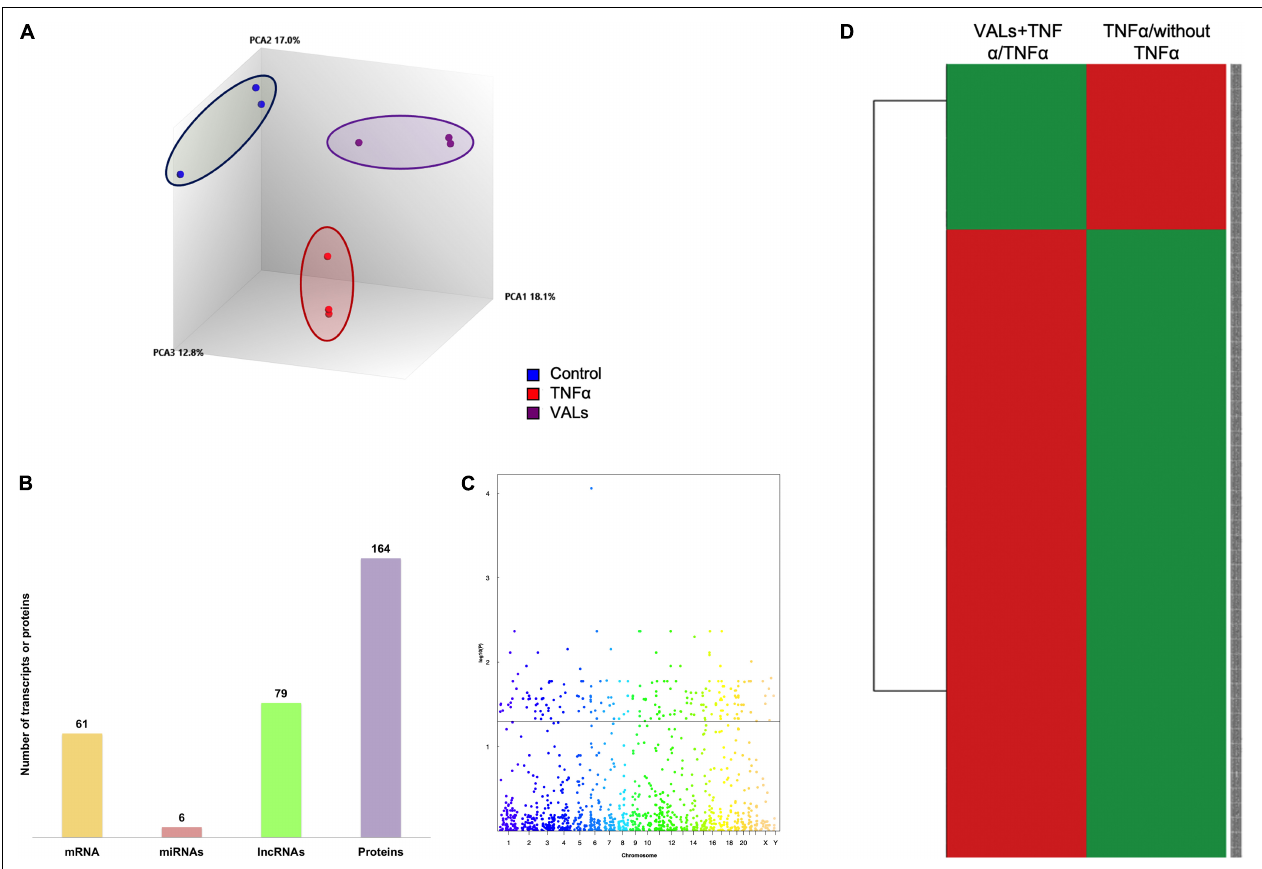
FIGURE 3 | Genomic modifications induced by γ -valerolactones treatment in human brain microvascular endothelial cells. HBMEC cells exposed to the mixture of gut metabolites ( γ -valerolactones) for 20 h and induced under stress by 4 h-incubation with TNF- α were used in microarray analysis and proteomic analysis to determine the differential expression of transcripts and proteins between groups, respectively. (A) A 3D Principal component analysis (PCA) plot of the data that characterizes the trends exhibited by the expression profiles of HBMEC cells not treated with TNF- α (control, blue), cells treated with TNF- α (TNF- α , red), and cells treated with VALs + TNF- α (VALs, purple). Each dot represents a sample and each color represents the type of the sample. (B) Histogram of the number of differentially expressed mRNAs, miRNAs, lncRNAs and proteins. (C) Manhattan plot of total transcripts, 211 transcripts positioned above the line were considered differentially expressed. (D) Heatmap analyses of gene expression profiles between VALs + TNF- α /TNF- α and TNF- α /without TNF- α . Rows are centered with unit variance scaling applied to rows. Rows are clustered using Euclidean distance and Ward linkage. The levels of gene expression are shown in colors, which transition from green to red with increasing